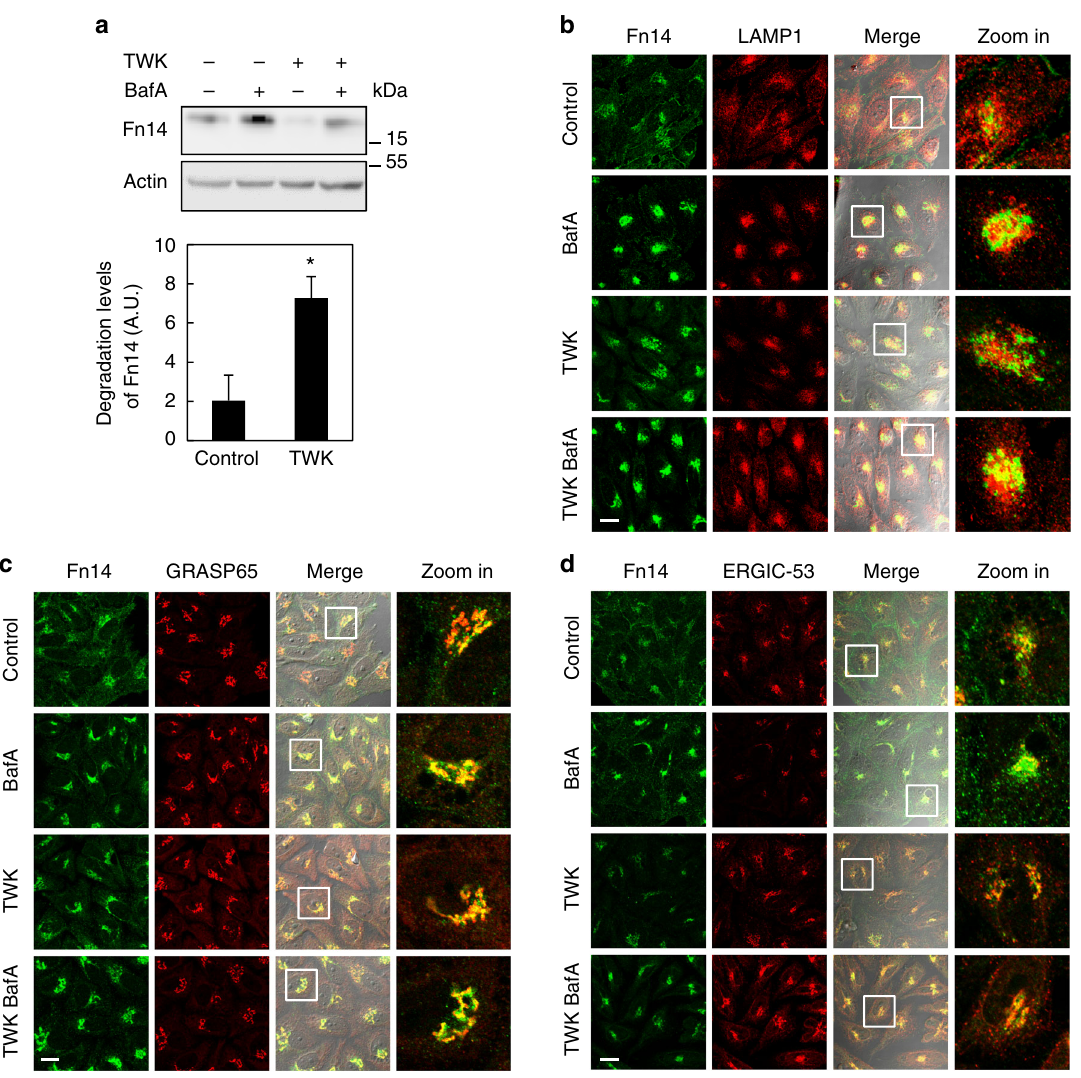
Fig. 1 Fn14 is degraded in lysosomes and undergoes traf fi cking through Golgi. a HeLa cells were treated with BafA and TWK as indicated, extracted proteins were immunoblotted (upper panel) and lysosomal fl ux was calculated (lower panel) (* P < 0.05, n = 7 biological repeats). b – d Cells were treated as in a , immunostained for Fn14 and LAMP1 ( b ), GRASP65 ( c ), or ERGIC-53 ( d ), and analyzed by confocal microscopy (scale bar, 20 µ m). Large magni fi cation of stained cells is presented in the right column. Comparisons by T test; mean ±